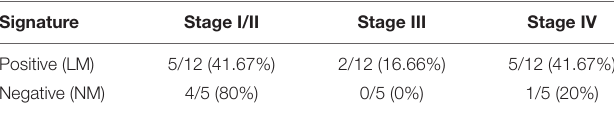
TABLE 2 | LncRNA signature and disease